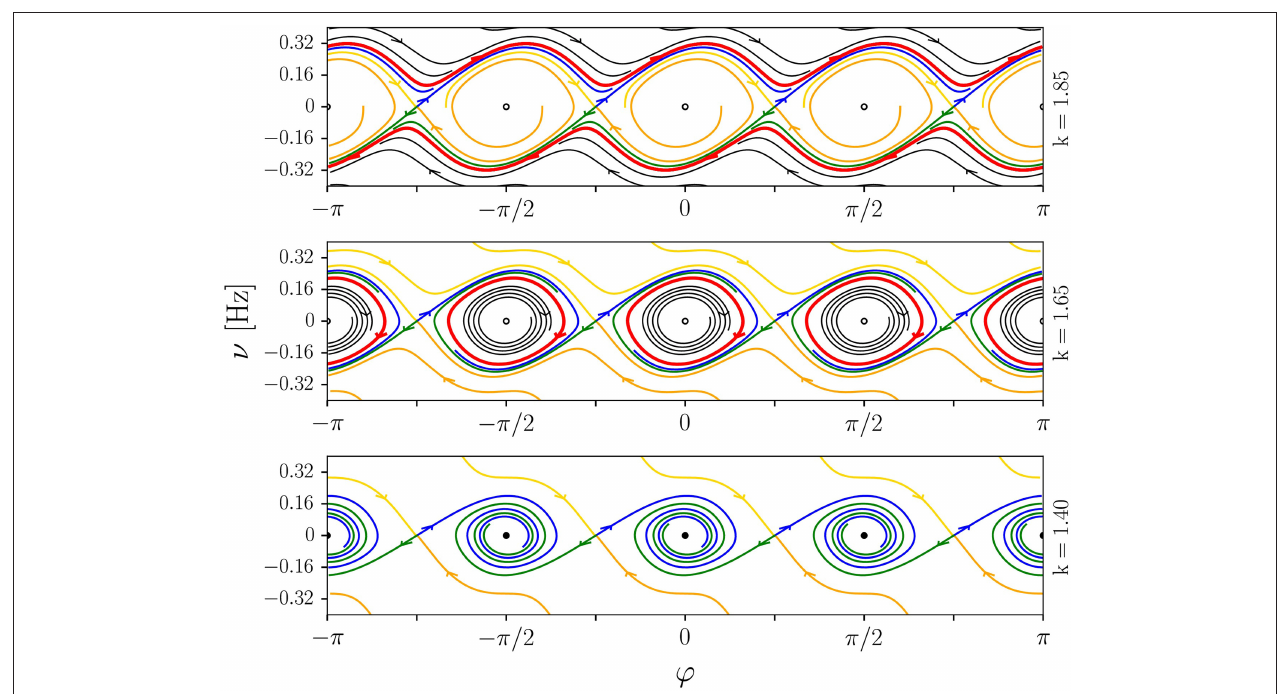
FIGURE 8 | Illustration of the homoclinic route to locomotion discussed in section 4.2. The phase-space plots ( ϕ , ν = ω/ (2 π )) are for the analytic model (13), with a = 4, τ = 0.25, I = 0.05, and f = 0.5. The spring constant is k = 1.85 / 1.65 / 1.4 (top/middle/bottom). The fixpoints located at odd multiples of π/ 4 are saddles. Shown are stable (yellow/orange) and unstable (blue/green) manifolds, limit cycles (red), stable and unstable foci (filled/open circles) and some selected generic trajectories (black). Top : Limit-cycle locomotion, with the stable orbit winding around ϕ ∈ [ − π , π ]. Middle : Forth-and-back rolling with the angle ϕ of the wheel being limited to a finite range around multiples of π/ 2. Bottom : Stationary states with ϕ → n π/